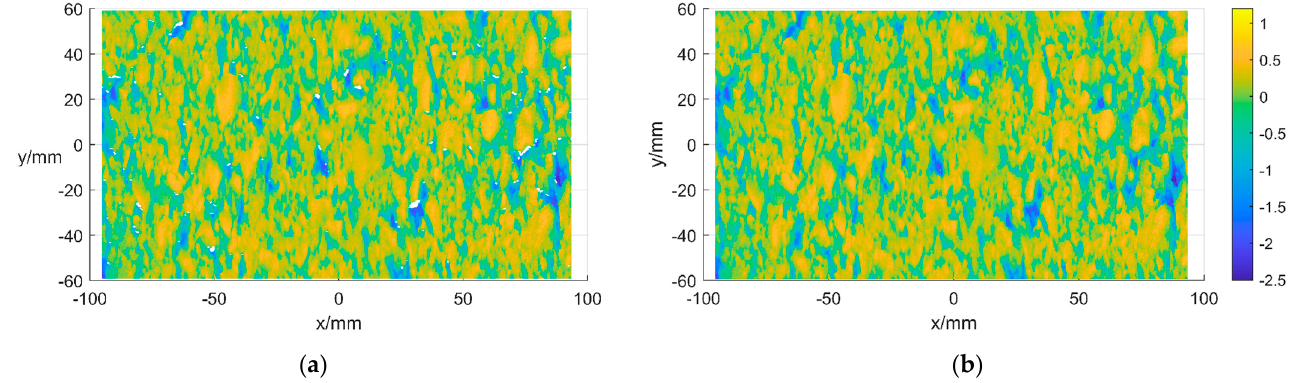
Figure 3. MP of pavement texture. ( a ) Pavement texture before MP. ( b ) Pavement texture after MP.